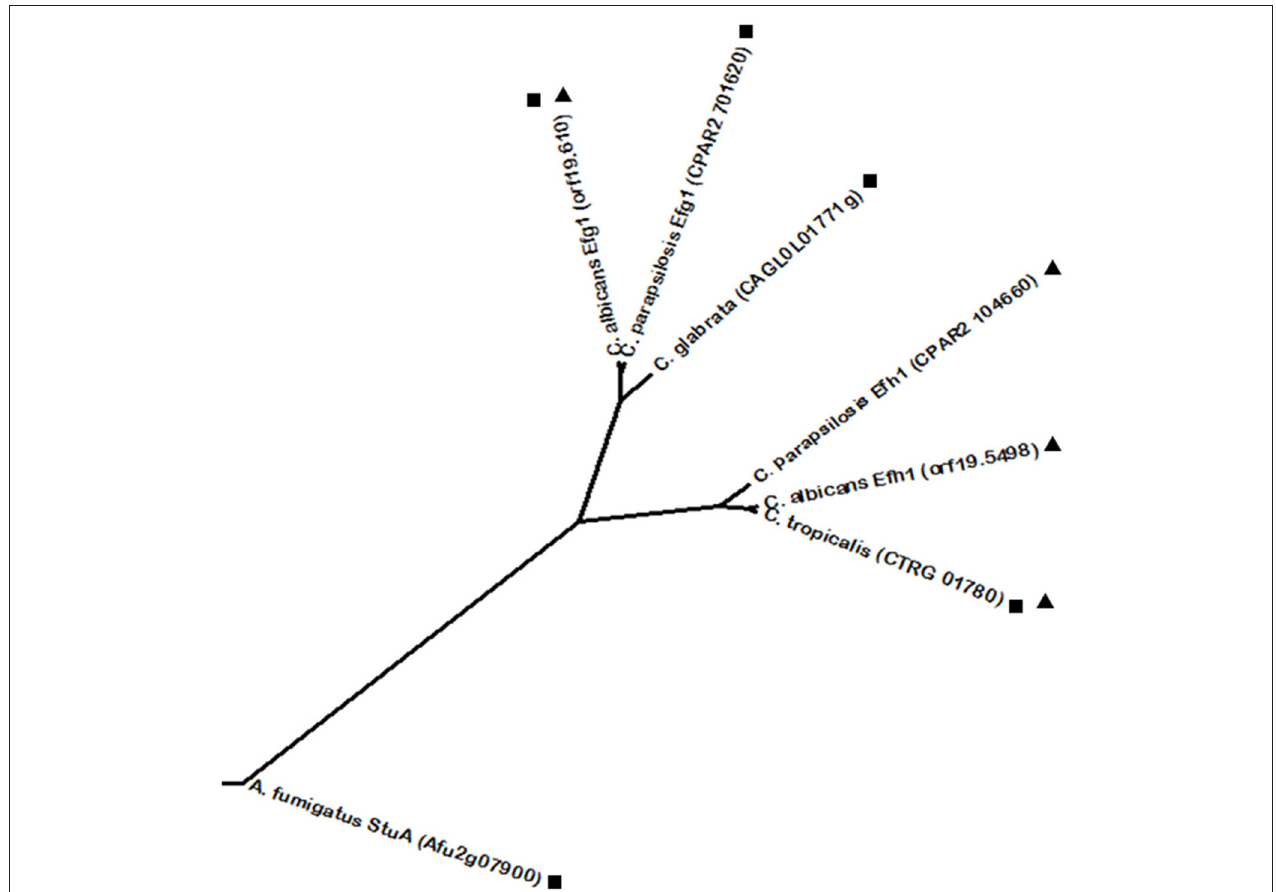
FIGURE 3 | Phylogenetic analysis of the C. albicans Efg1 and Efh1 homologs. Phylome predicted homologs of Efg1 are marked with ( (cid:4) ). Phylome predicted homologs of Efh1 are marked with ( N ). The tree was constructed using the Molecular Evolutionary Genetics Analysis (MEGA 7) software (Kumar et al., 2016). Multiple alignments of the amino acid sequences were calculated by ClustalW algorithm (Sneath and Sokal, 1973). The tree is drawn to scale, with branch lengths in the same units as those of the evolutionary distances used to infer the phylogenetic tree. The evolutionary distances were computed using the JTT matrix-based method (Jones et al., 1992) and are in the units of the number of amino acid substitutions per site. The rate variation among sites was modeled with a gamma distribution (shape parameter = 1).